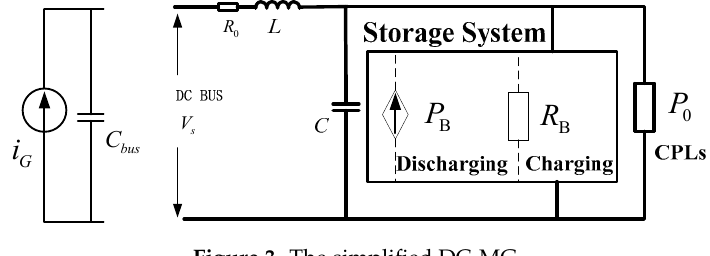
Figure 3. The simplified DC-MG.